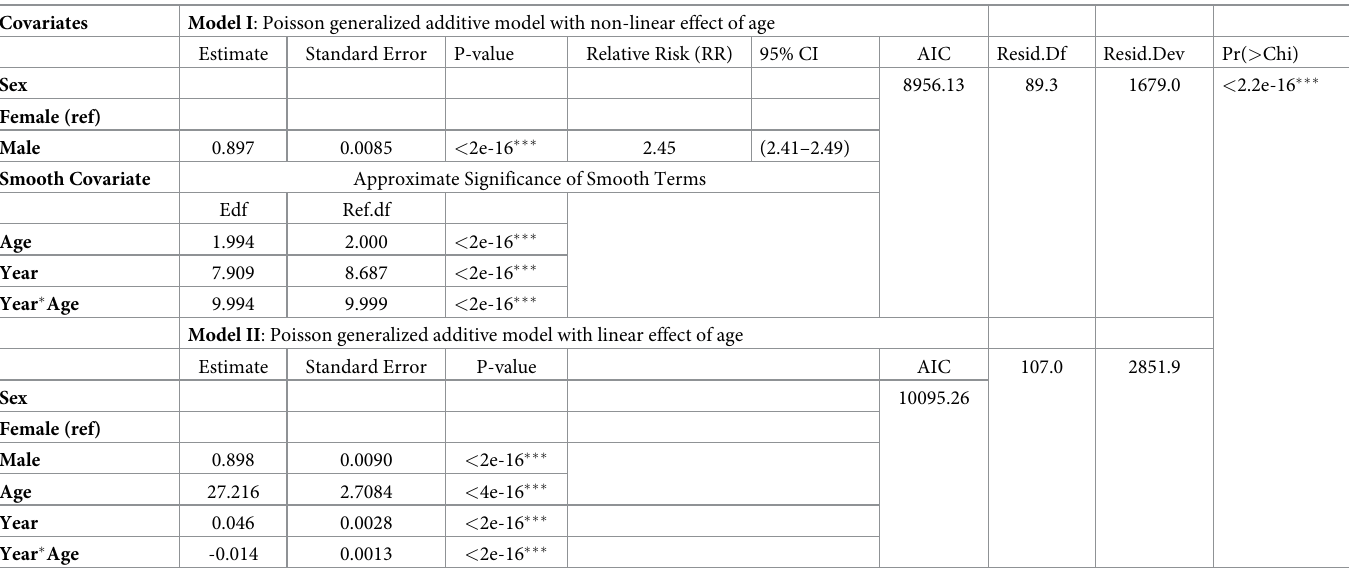
Table 3. Models assessing the linear and non-linear effect of age. Model I : Poisson generalized additive model with non-linear effect of